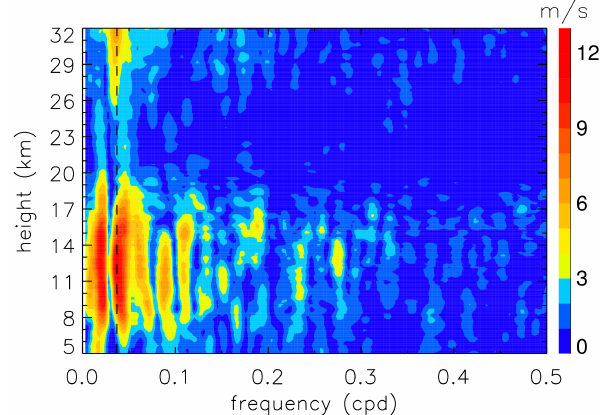
Figure 5. Lomb–Scargle spectrum of zonal wind at 5–32km from radiosonde observations over Hilo. The dotted vertical line corre- sponds to a period of 27 days.